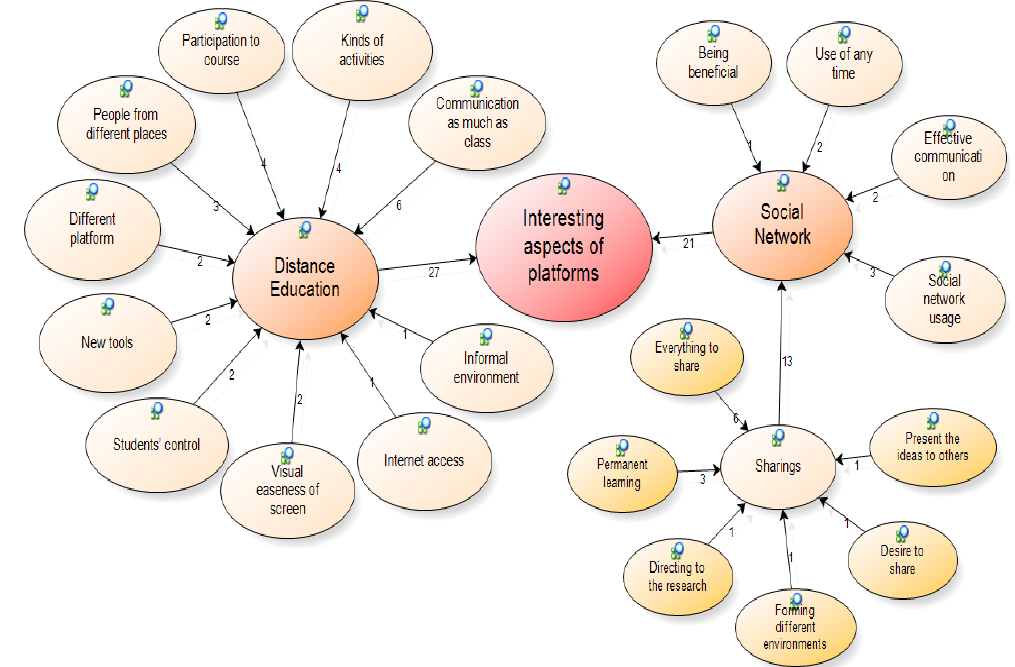
Figure 6. Model related to the interesting aspects of the